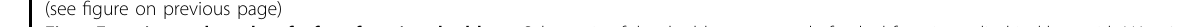
p2 Green metasurface